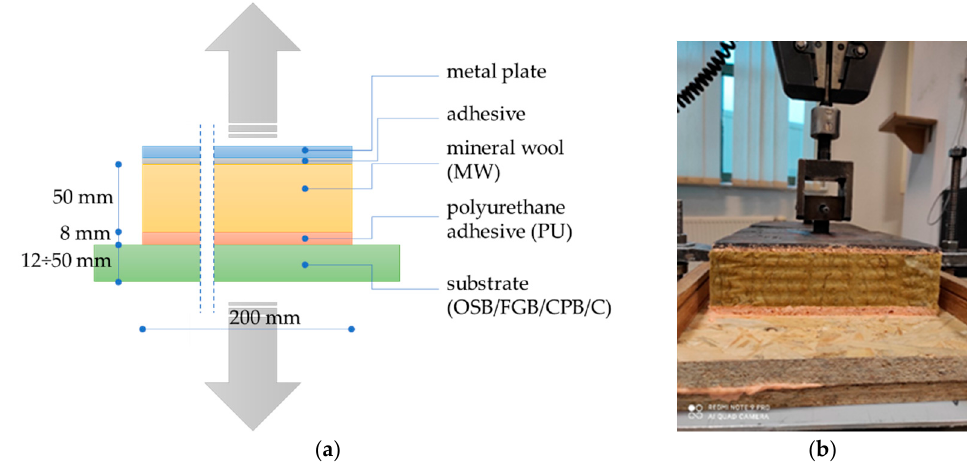
Figure 3. Bond strength test: ( a ) sample scheme, ( b ) sample from OSB/23/50/8 series under load in the testing